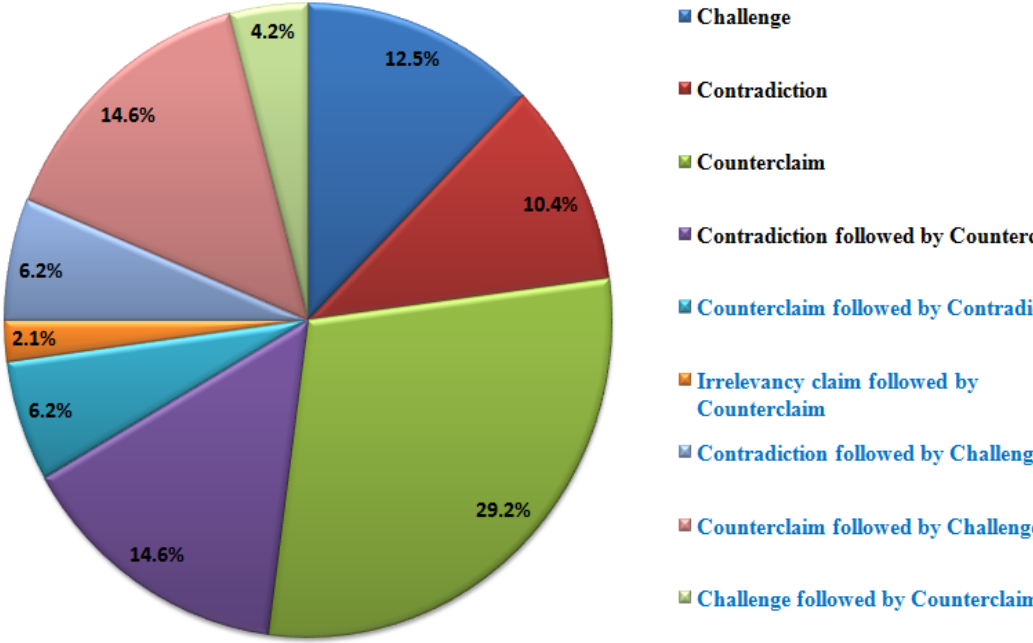
Figure 2: Female Criminals’ Disagreeing